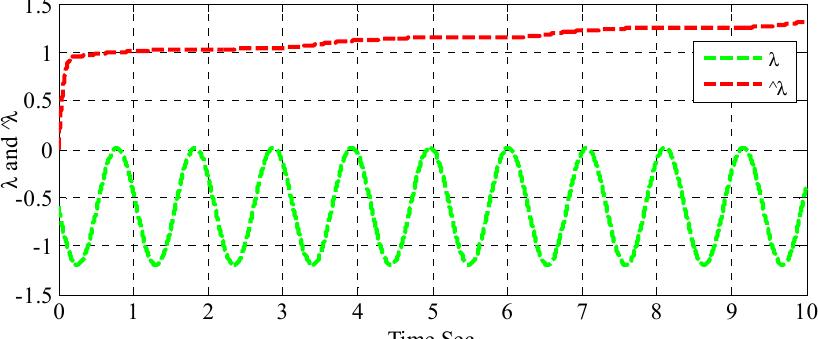
Figure 12. Sliding surface derivative 𝑠(cid:4662) (y-axis) versus sliding surface variable 𝑠 (x-axis) based on adaptive sliding mode backstepping controller 5. Conclusions Three contributions has been highlighted by the present work. The main contribution is to develop two adaptive control algorithms based on the design of adaptive backstepping control strategy and the design of adaptive backstepping-based sliding mode control scheme, for angular position control of electronic throttle valve plate. The second contribution is to prove the stability of the electronic throttle valve system based on these two adaptive control schemes using Lyapunov theory. The third contribution is to present a comparison study between adaptive backstepping control and adaptive sliding mode backstepping control strategies. The effectiveness of an adaptive backstepping controller and adaptive backstepping-based sliding mode controller have been examined using computer simulation based on MATLAB software. The performance comparison between the two adaptive controllers has been made and the simulated results showed that the adaptive sliding mode backstepping controller results in better performance in terms of both the transient and steady-state characteristics. However, the adaptive gain due to an adaptive backstepping controller showed closer convergence to real values, while an adaptive sliding mode backstepping controller could successfully estimate the upper bound of adaptive gain rather than tracking its real value. In an adaptive backstepping algorithm, the bound of disturbance is a prerequisite for the adaptive controller to work properly and estimate the disturbance. On the other hand, the adaptive backstepping sliding mode controller works to estimate this bound and therefore the problem of the need of the disturbance bound has been solved or avoided based on this controller.